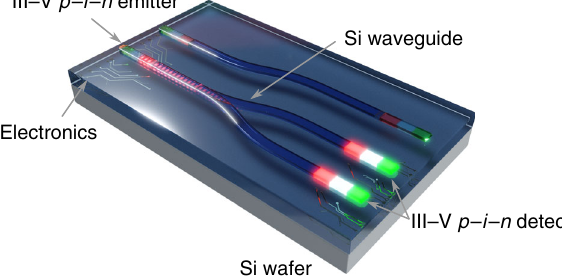
Fig. 1 Vision of a future all-optical link fabricated via TASE. Both emitter and detector can be integrated in-plane and butt-coupled to a Si waveguide. The present work employs free-space coupling but paves the way for future waveguide-coupled